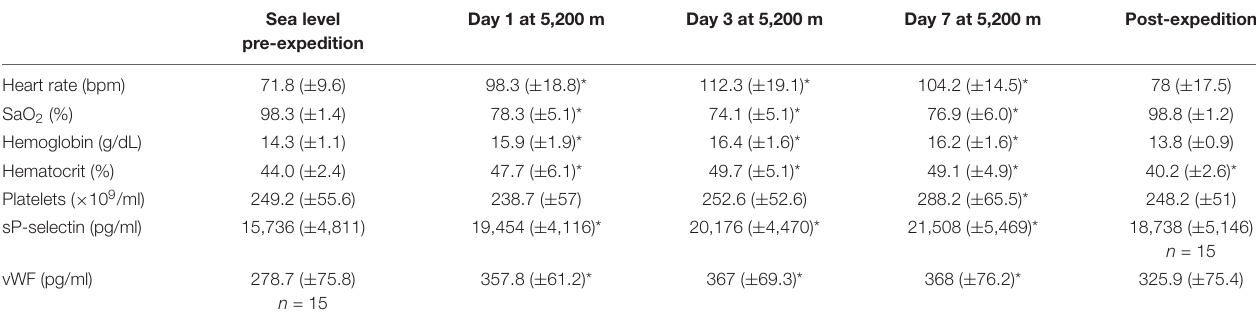
TABLE 1 | Physiological and hematological parameters of study participants at sea-level and altitude.